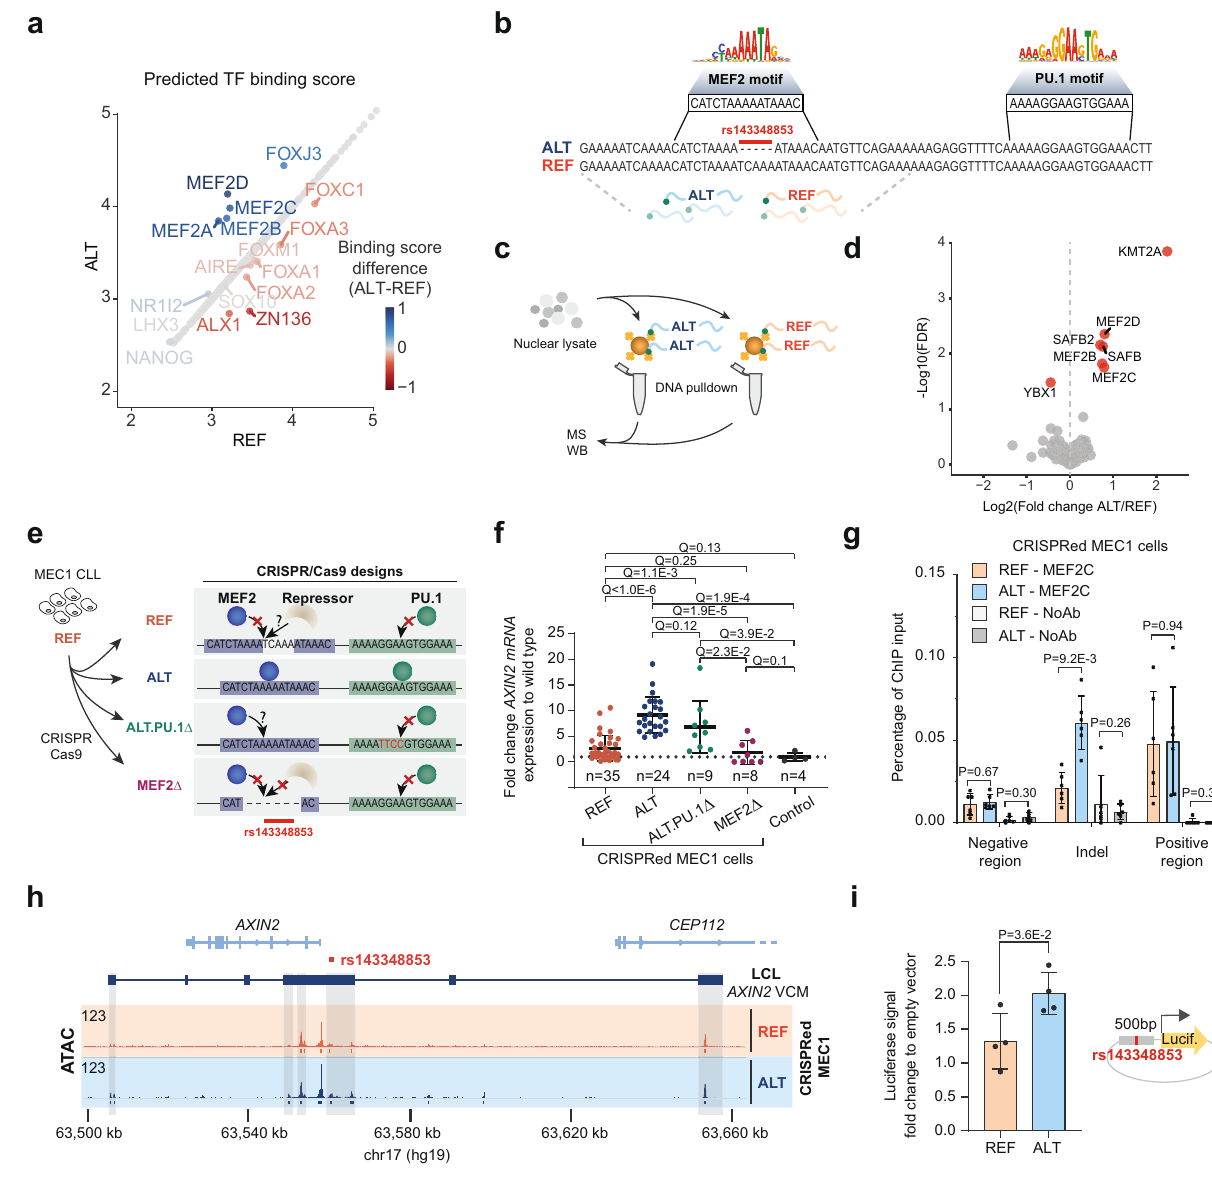
0.00.51.01.52.02.5 Lucif.500bp rs143348853 Fig. 4 De novo MEF2 TF-binding site formation by rs143348853. a Maximum TF-binding site Z-scores for both rs143348853 alleles across 757 bp around the indel. b DNA sequence representation of the indel region according to the NCBI dbSNP 23 build 154 of the two alleles, with a represented logo of MEF2(A) and PU.1-binding motifs based on ENCODE GM12878 data from Factorbook 112 . Underneath, the DNA sequences used for the pulldown experiment are highlighted. c Cartoon illustrating the in vitro DNA pulldown experiment with the DNA oligos (see b ) from the two different alleles, followed by mass spectrometry (MS) or western blotting (WB). d Bound TFs to ALT or REF DNA probes detected by in vitro DNA pulldown followed by MS for three replicates. Signi fi cant TFs are colored in red and labelled (FDR < 0.05). Only TFs 42 are shown. e Schematic of the CRISPR/Cas9 experiment to modify MEC1 CLL cells to validate the effect of rs143348853 on AXIN2 expression (ALT and REF) and to test two additional scenarios: ALT.PU.1 Δ and MEF2 Δ . Control cells are clones that received the plasmid but did not undergo homologous recombination (2 clones for each ALT and REF construct). f Each value represents the fold change of AXIN2 mRNA expression assessed by qPCR relative to wild-type MEC1 cells derived from a single and different clone. n indicates the number of clones assessed for each group. Q represents the FDR adjusted p- value. g MEF2C ChIP-qPCR-based enrichment on distinct regions in the CRISPRed MEC1 cells ( n = 6 biological replicates). h ATAC-seq signal on the AXIN2 VCM region of CRISPRed MEC1 cells. The track is the combination of three biological replicates (read sum). Below each track, called peaks for each genotype are displayed. i Dual reporter luciferase assay performed in MEC1 cells to test the enhancer capacity of a 500 bp sequence centered on the indel for both genotypes ( n = 4 biological replicates). In f , g , and i , data are presented as the mean ± SD, P represents p -values from an unpaired two-sided Welch ’ s t -test, corrected for multiple testing by FDR when necessary (de fi ned as Q), and source data are provided as a Source Data fi le. rs143348853 alone is responsible for AXIN2 expression and Fig. 8b) (note, MEF2A was enriched in ALT but not signi fi cantly). enhancer activation . Our analyses so far demonstrated a direct No other candidates from the in silico analysis were detected correlation between indel presence and activity status of the (ZNF136 or FOXM1) nor emerged as being differentially bound AXIN2 VCM. To investigate causality, we used CRISPR/Cas9 (FOXJ3). NATURE COMMUNICATIONS| (2022) 13:2042